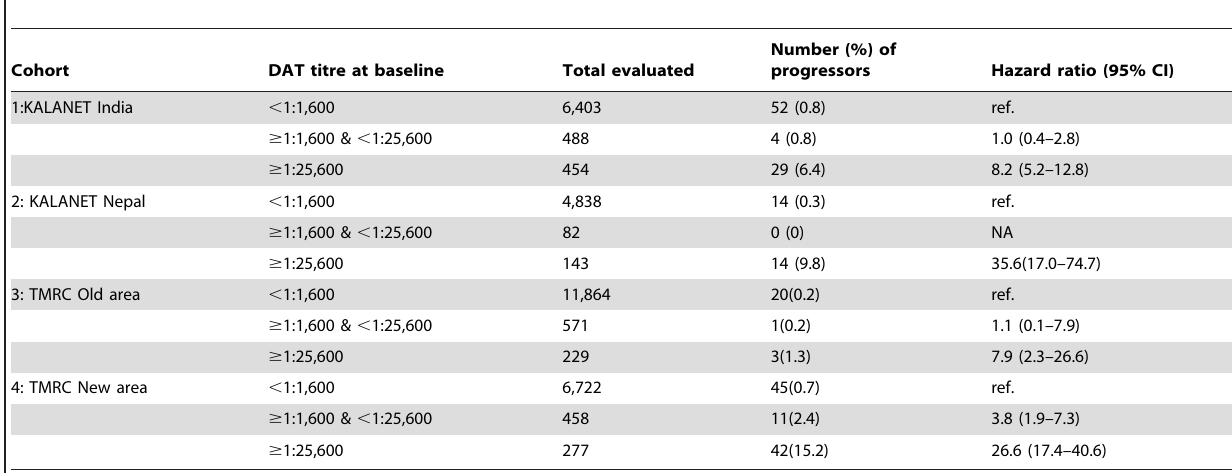
Table 2. Risk of progression to clinical VL in groups of individuals classified as seronegative, moderately seropositive and strongly seropositive according to their baseline DAT titers.